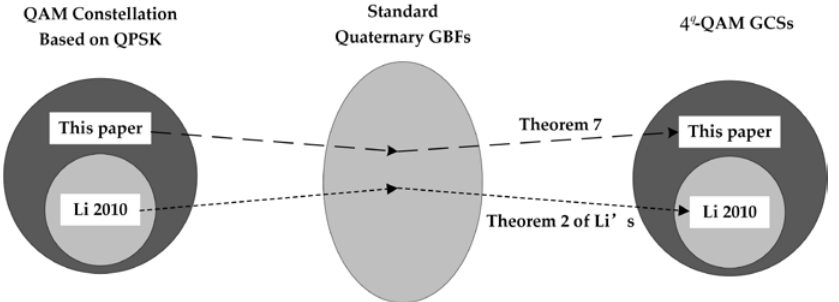
Figure 2. The process from the QAM constellation to the QAM GCSs, and the relationship between [23] and this paper.